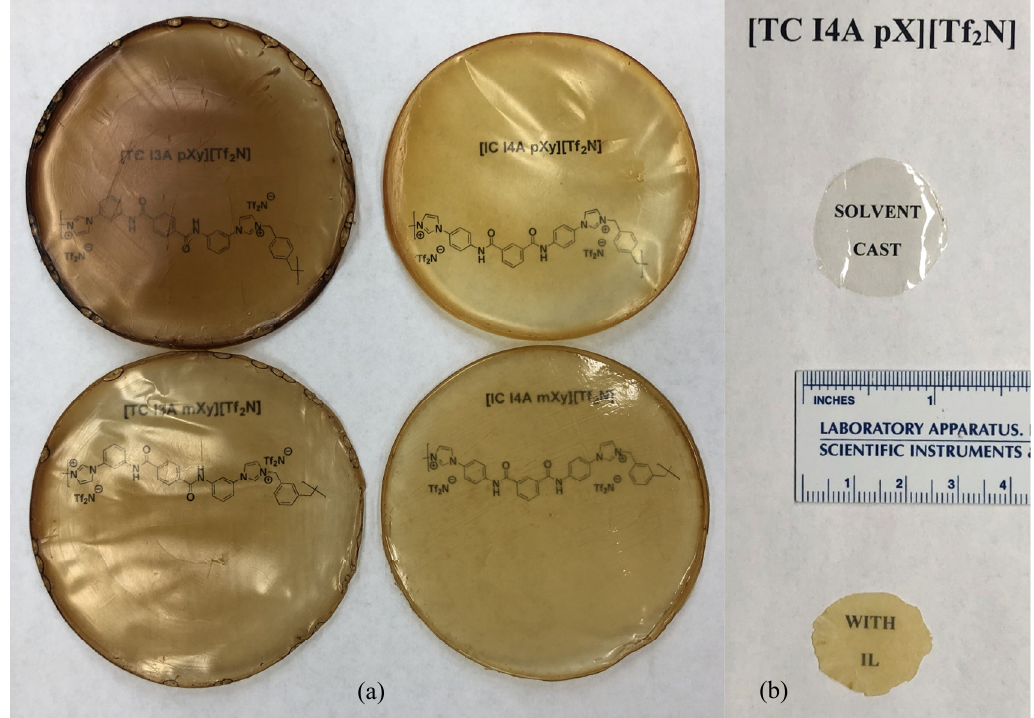
Figure 4. ( a ) Images of solvent cast films (d = 60 mm) of four PA-ionenes introduced in this work; ( b ) Comparison of [TC I4A pX][Tf 2 N] as a neat solvent cast film versus ionene-containing [Bnmim][Tf 2 N].